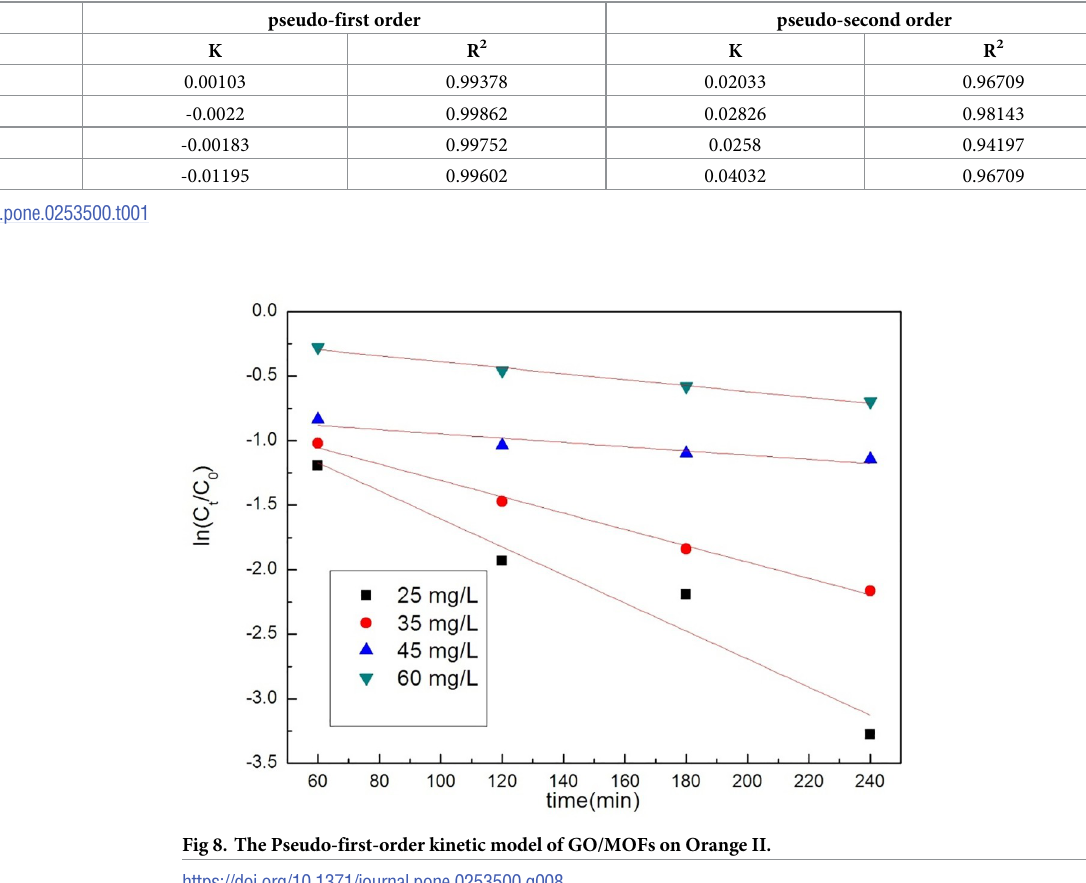
Table 1. Parameters of the process of tetracycline hydrochloride by GO/MOFs.